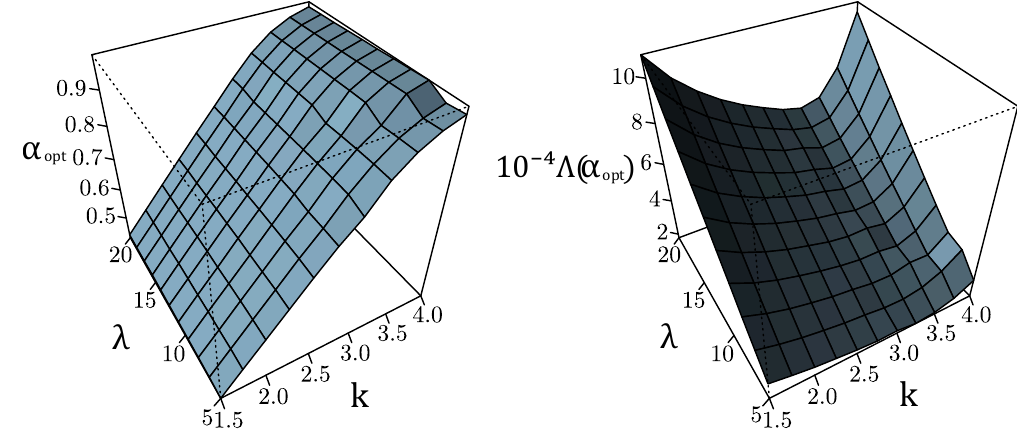
Figure A1. ( a ) Optimal exponent α opt as a function of the shape parameter k and the scale parameter λ of the Weibull distribution. ( b ) Minimal value Λ ( α opt ) of the distance measure in Equation (A5) associated with the optimal